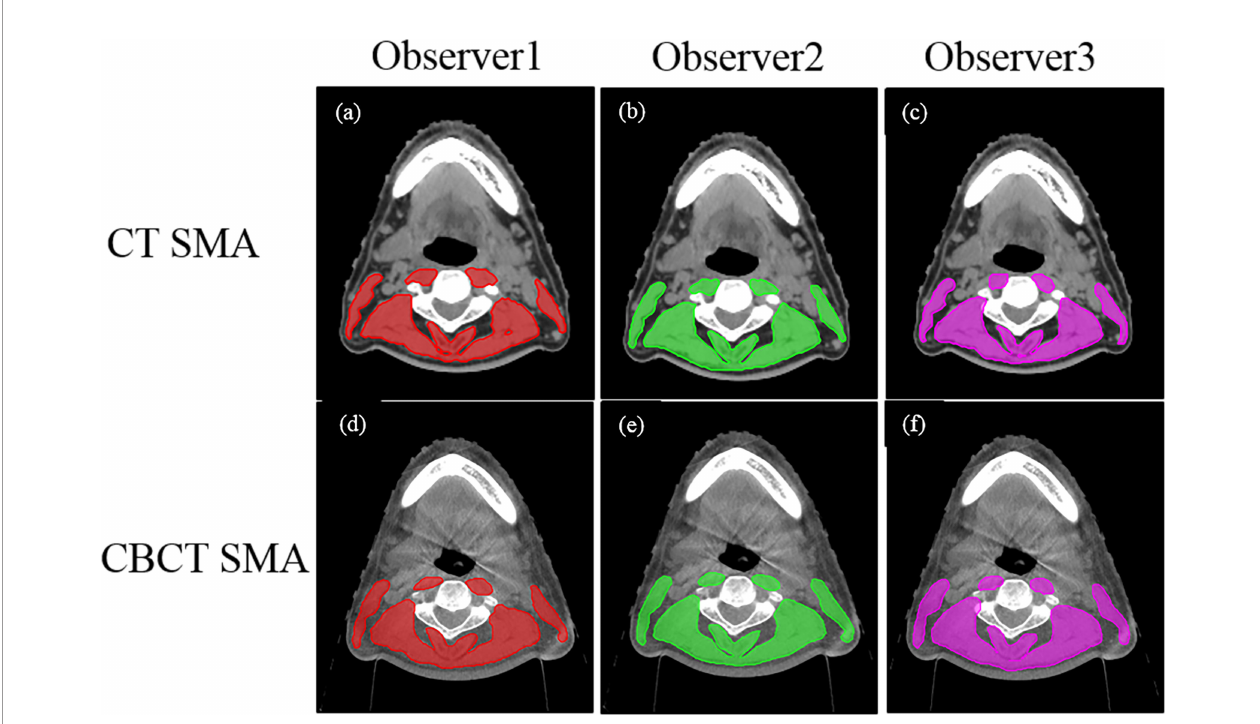
FIGURE 1 | Computed tomography (CT) and cone-beam CT (CBCT) images identi fi ed by three independent senior radiation oncologists (observers 1, 2, 3). The upper panel (A – C) shows the CT skeletal muscle mass (29 – 150 HU) and the lower panel (D – F) shows the CBCT skeletal muscle mass (observer 1, red; observer 2, green; observer 3,